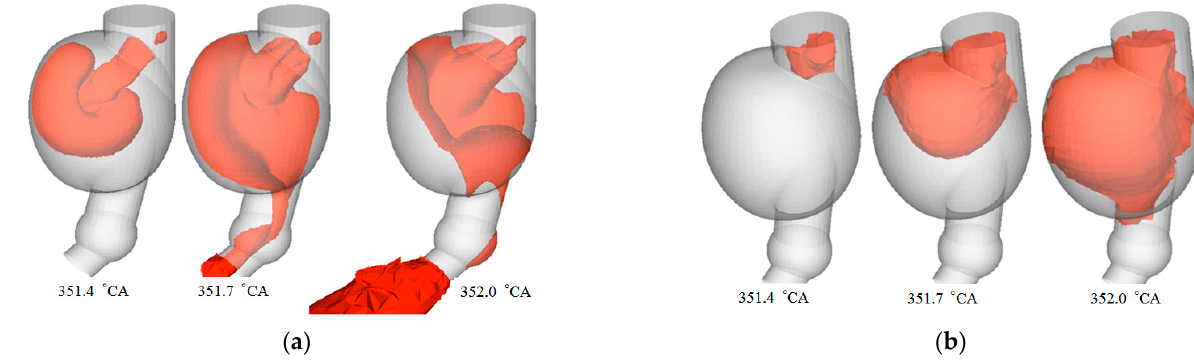
Figure 5. Development of flame front in pre-chamber of ( a ) case 1 and ( b ) case 3. Flame front defined as 1400 K isosurface.